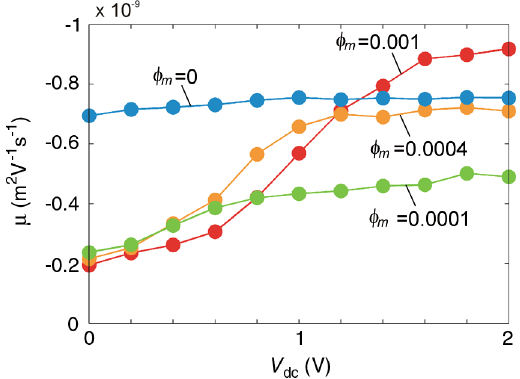
FIG. 5. Mobility measurement of four particles of 3 : 38 (cid:1) m radius optically trapped in the midplane between the electrodes, for different surfactant concentrations (cid:2) m and different applied voltages V dc . In the absence of surfactant ( (cid:2) m ¼ 0 ), the mobility is independent of the increasing dc voltage. When the solution contains surfactant, the mobility increases for increasing values of V dc , because the micellar ions or charged reverse micelles are gradually separated, thereby reducing the electrophoretic retarda- tion. The saturation value is reached for values of V dc around 2